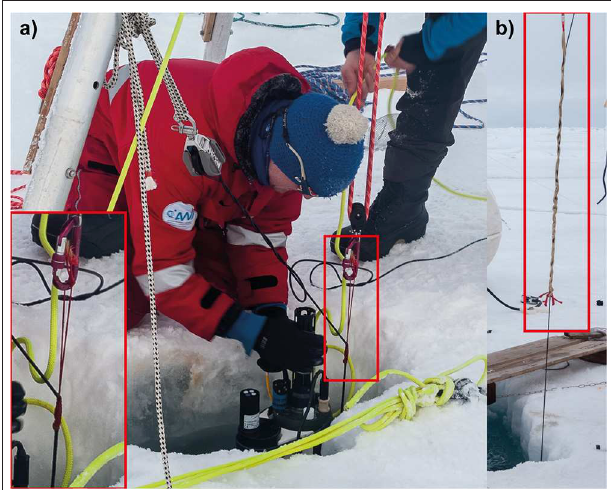
how the un-tensioned steel wire immediately twists above the knot, making reuse of the wire difficult. (b) A Yale grip partially holding the weight of the system during deployment of a profiler. Both pictures were taken during the training session, where a bigger tripod was